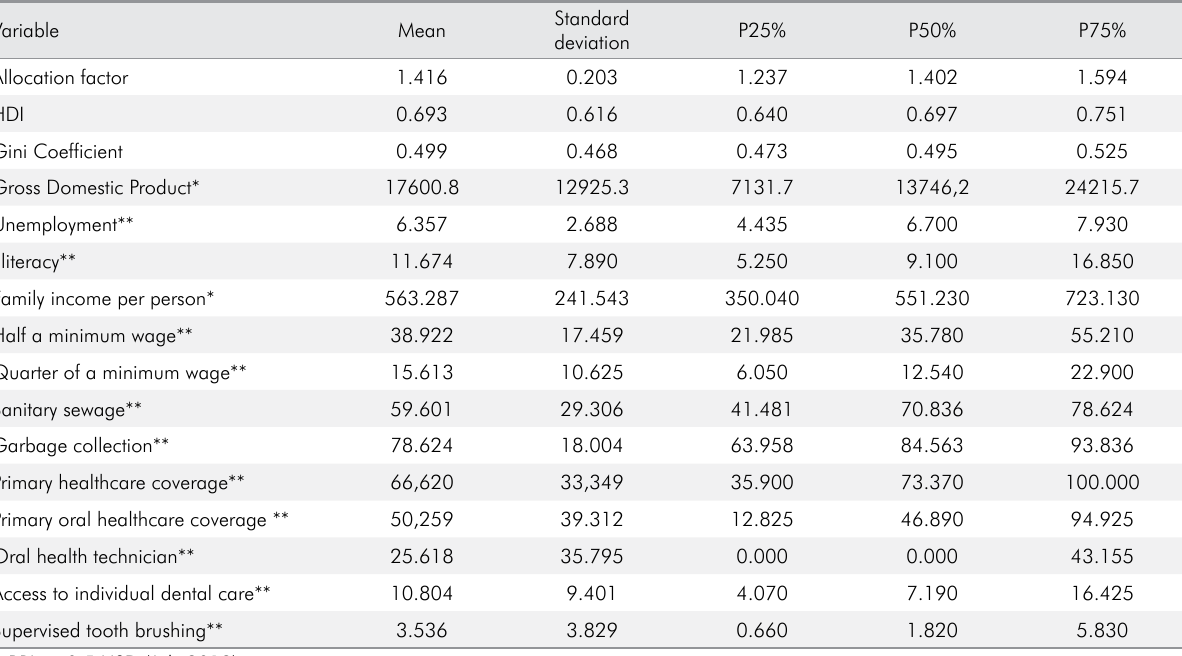
Table 3. Descriptive analysis of contextual variables from municipalities in a southeastern state of Brazil, 2012 Variable